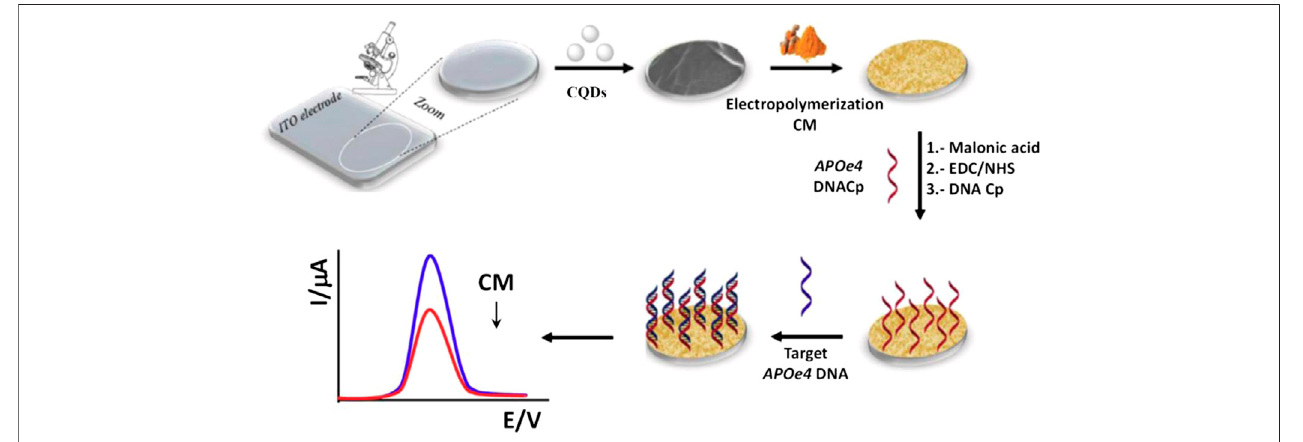
FIGURE 14 | Schematic representation of the electrochemical DNA biosensor. Reprinted with the permission from (Campuzano et al., 2019).